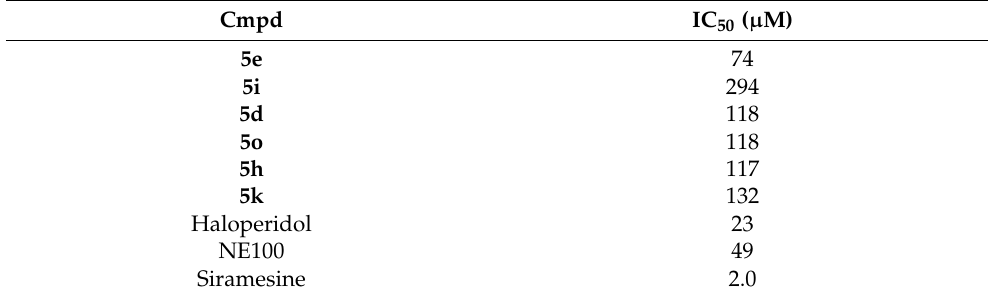
Table 4. IC 50 values for compounds 5e, 5i, 5d, 5o, 5h , and 5k .